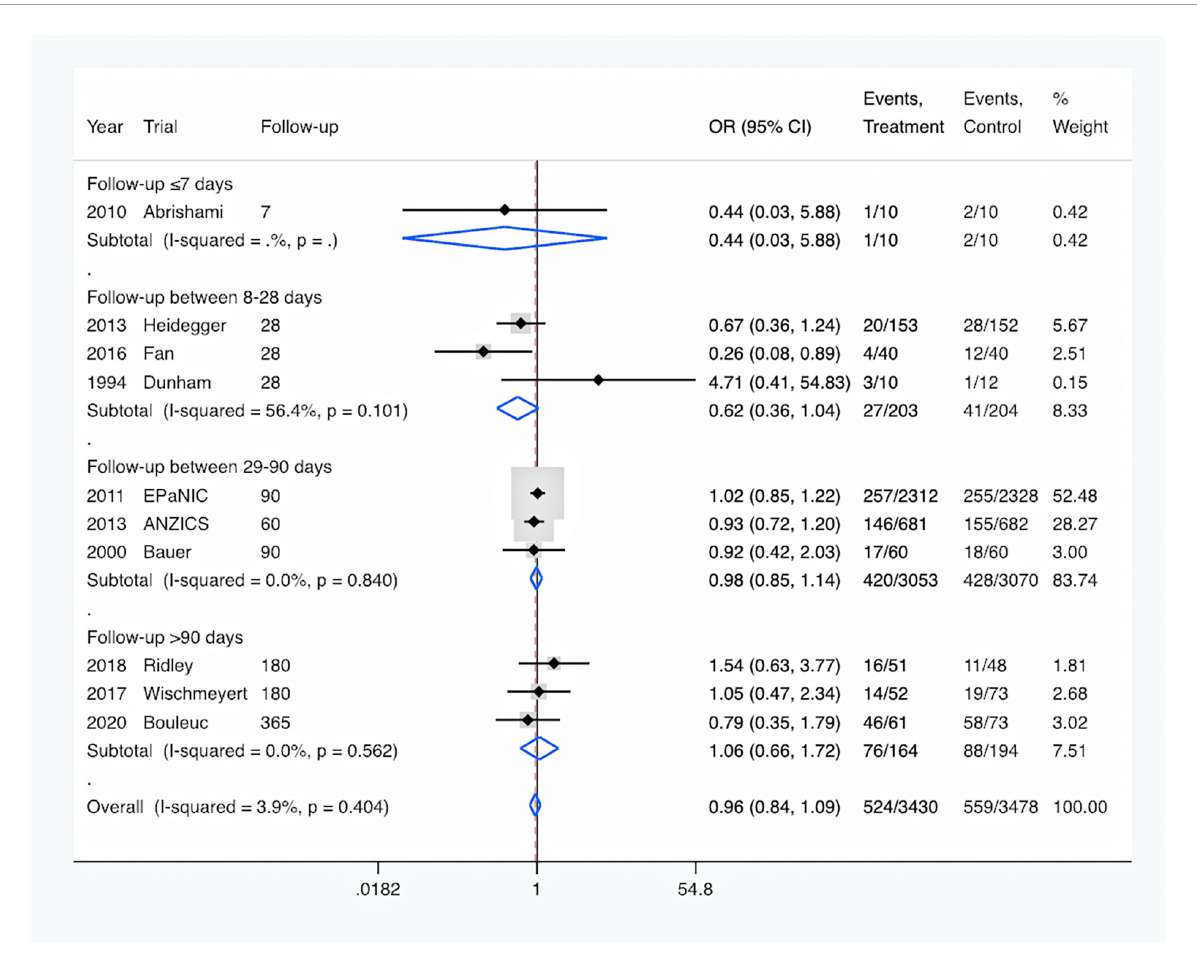
FIGURE2 Effect of SPN and EN nutrition support treatment on all-cause